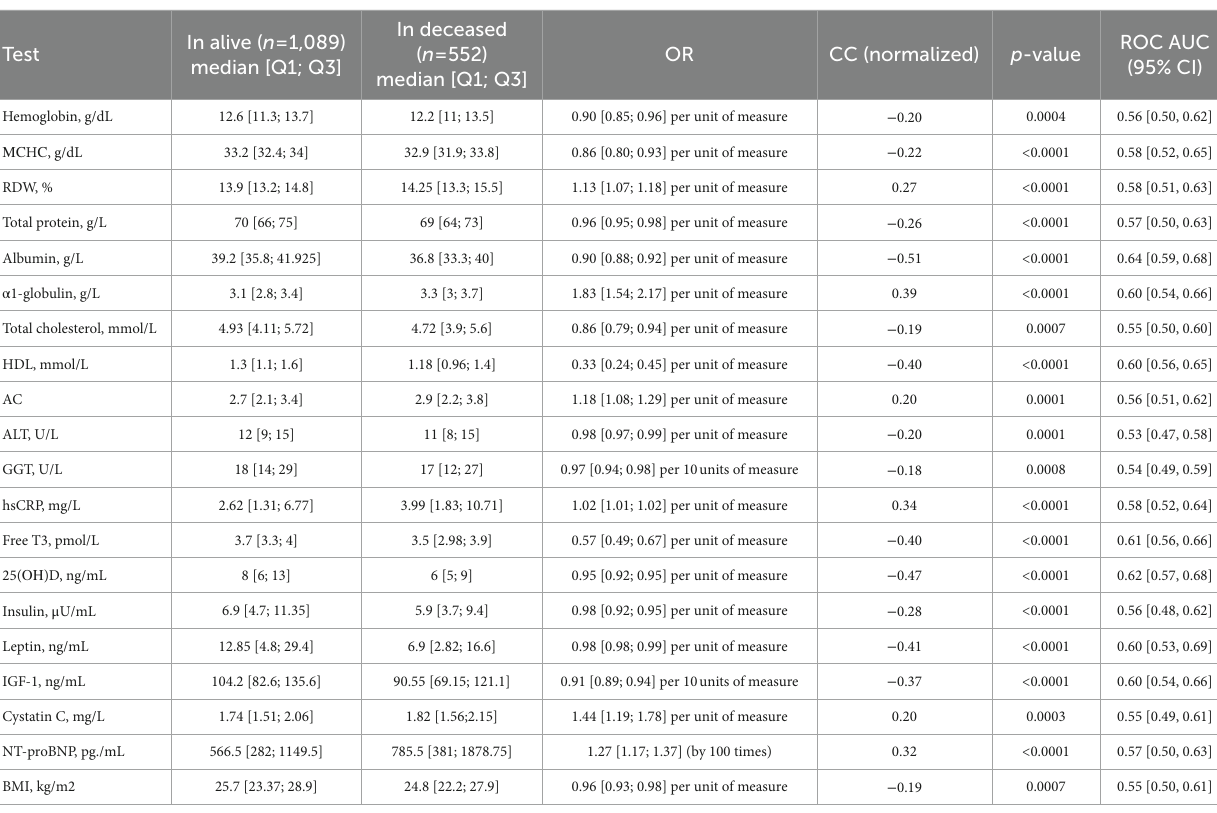
TABLE 4 Associations (only significant) between the test results and 1-year all-cause mortality, adjusted for sex, age, and multiple testing. In deceased In alive ( n = 1,089) Test ( n = 552) median [Q1; Q3] Hemoglobin, g/dL